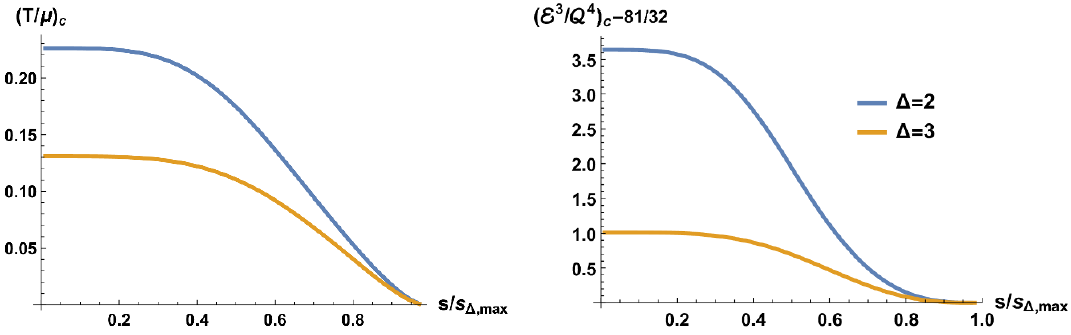
Figure 2 . Critical value of T=(cid:22) and E 3 below which Z 2 symmetry of the RN phase is spontaneously Q 4 (cid:12) (cid:12) broken. E 3 = 81 and s (cid:1) ; max is the maximal value of the bulk parameter s (3.3), determined (cid:12) Q 4 32 extremal by (3.8). The blue and orange curves refer to (cid:1) = 2 ;